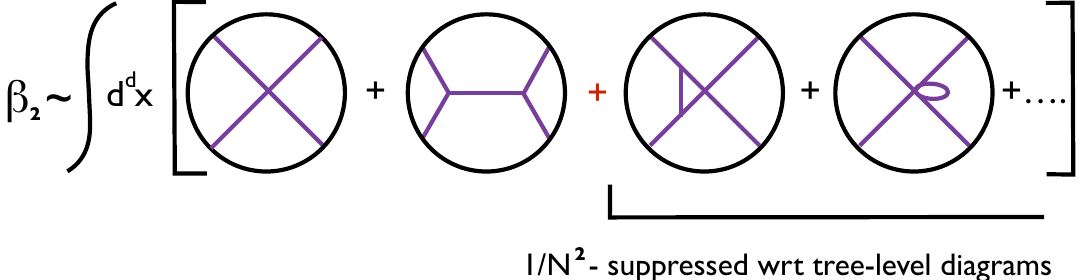
Figure 5. Structure of Witten diagrams contributing to the two-loop coe(cid:14)cient of (cid:12) ( g ), after integration in d d x . Conventions are as in (cid:12)gure